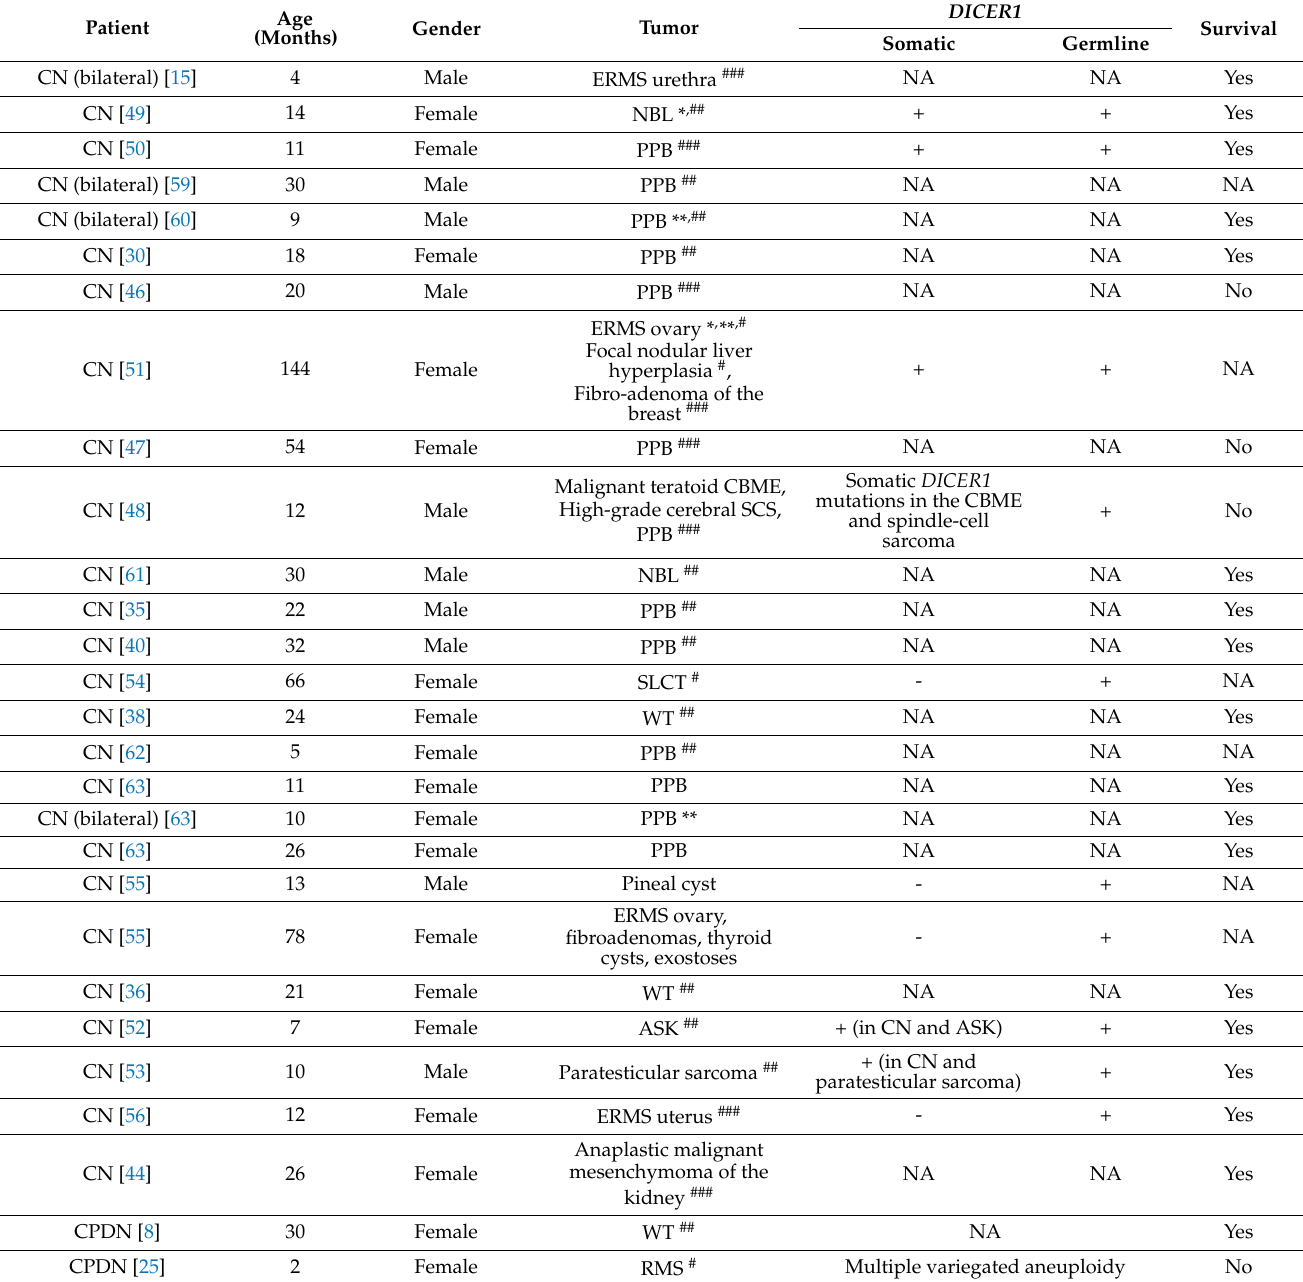
Table 6. Other tumors identified in patients with CN and